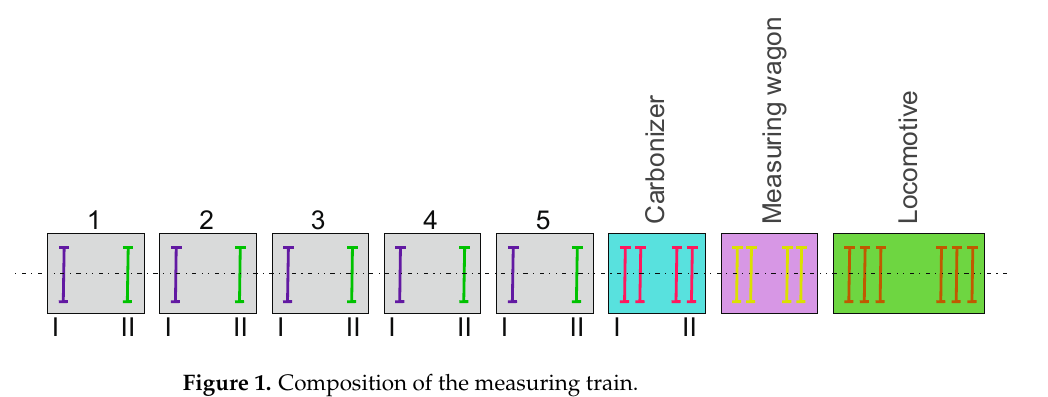
Figure 1. Composition of the measuring train.